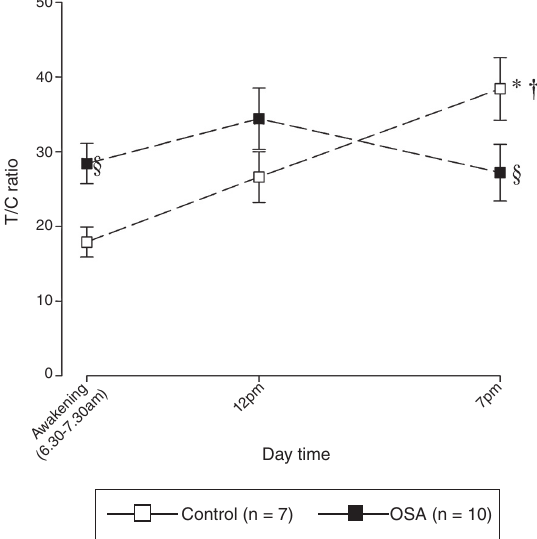
Figure 2 Diurnal trajectories of the T/C ratio in the study population. The data are presented as the mean ± SEM. Statis- tical analysis: a two-way ANOVA followed by post-hoc test for multiple comparisons, * p < 0.001 vs. the value at 7 am; † p < 0.05 vs. the value at 12 pm; § p < 0.05 vs. the corresponding control. In both the control and OSA groups, the salivary Cortisol concentration in the morning (7.2 ± 0.6 ng/mL and 4.6 ± 1.0 ng/mL, respectively) was significantly higher than that in the evening (2.5 ± 0.4 ng/mL, p < 0.001 and 2.1 ± 0.1 ng/mL, p < 0.001, respectively). Furthermore, in